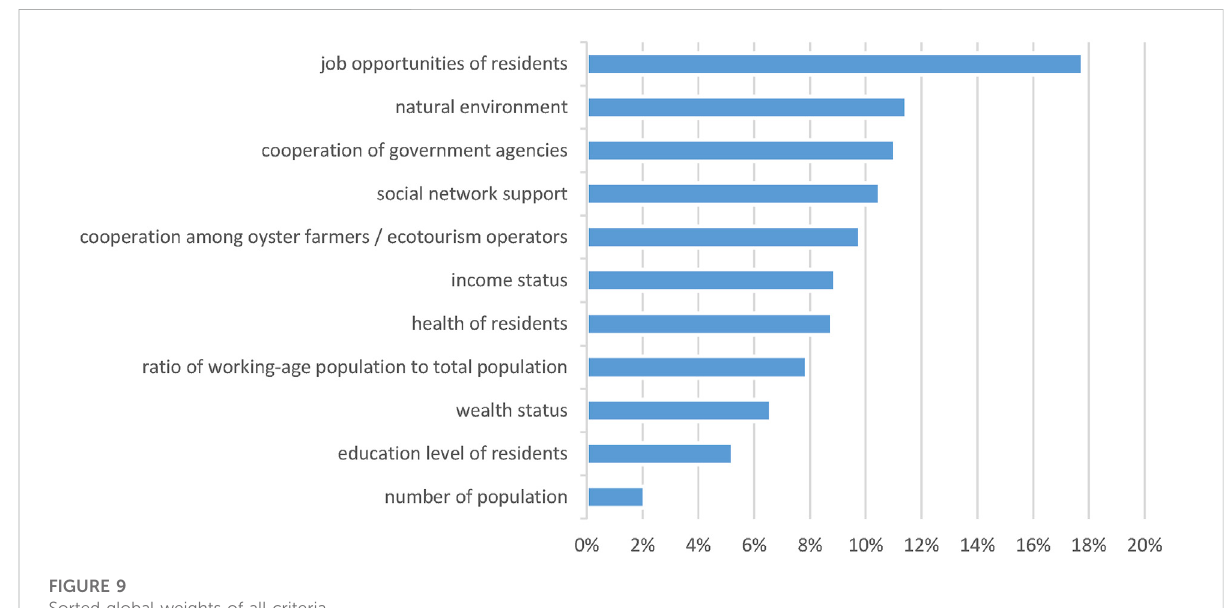
FIGURE 9 Sorted global weights of all